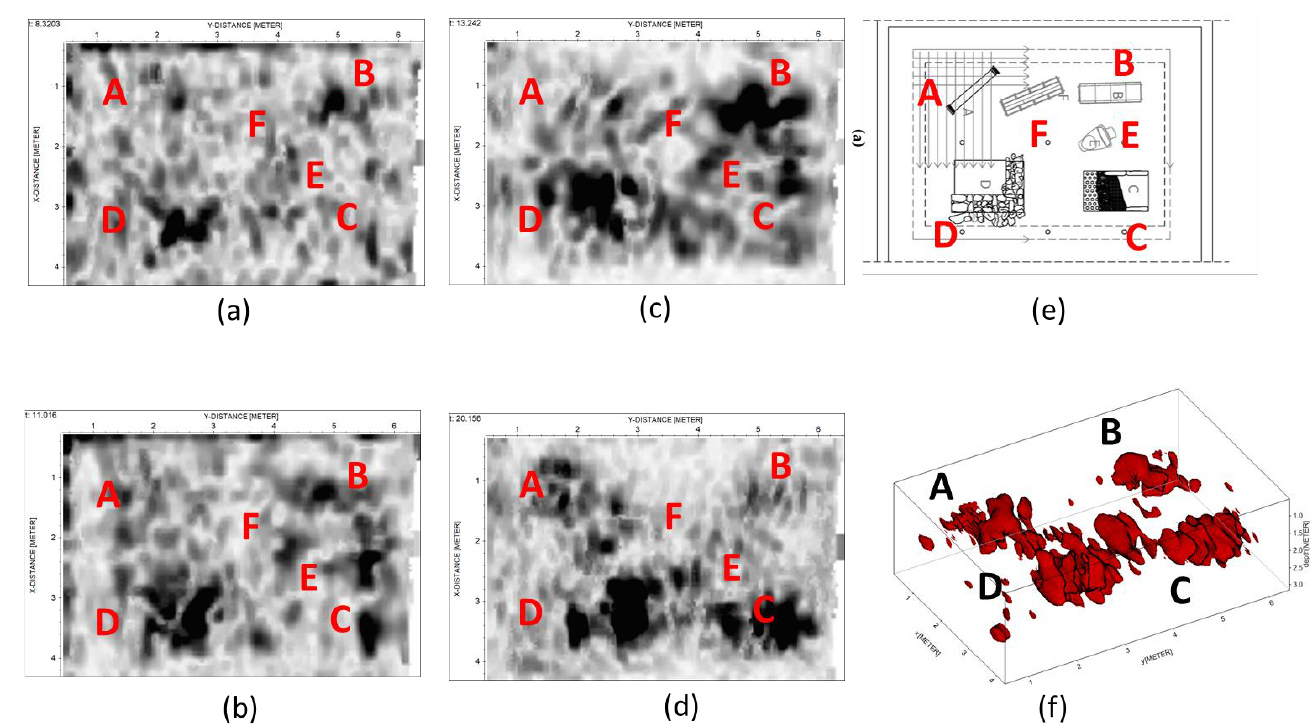
Figure 6. Time-slices at the depths of 0.25 m ( a ), 0.45 m ( b ), 0.70 m, and ( c ) 1.00 m ( d ) with a water table at a depth of 1.50 m (WL3). In ( f ) the 3D iso-amplitude volumes obtained selecting only the highest reflections; ( e ) the plane of the test site.